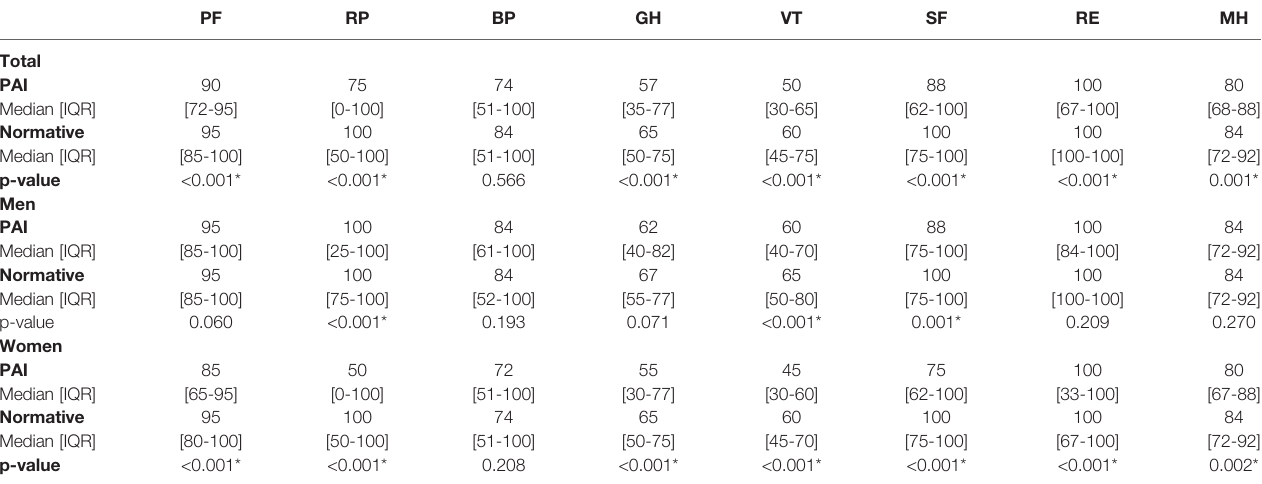
TABLE 2 | RAND-36 subdomain scores in patients (Men, Women, and Total) with PAI compared with normative